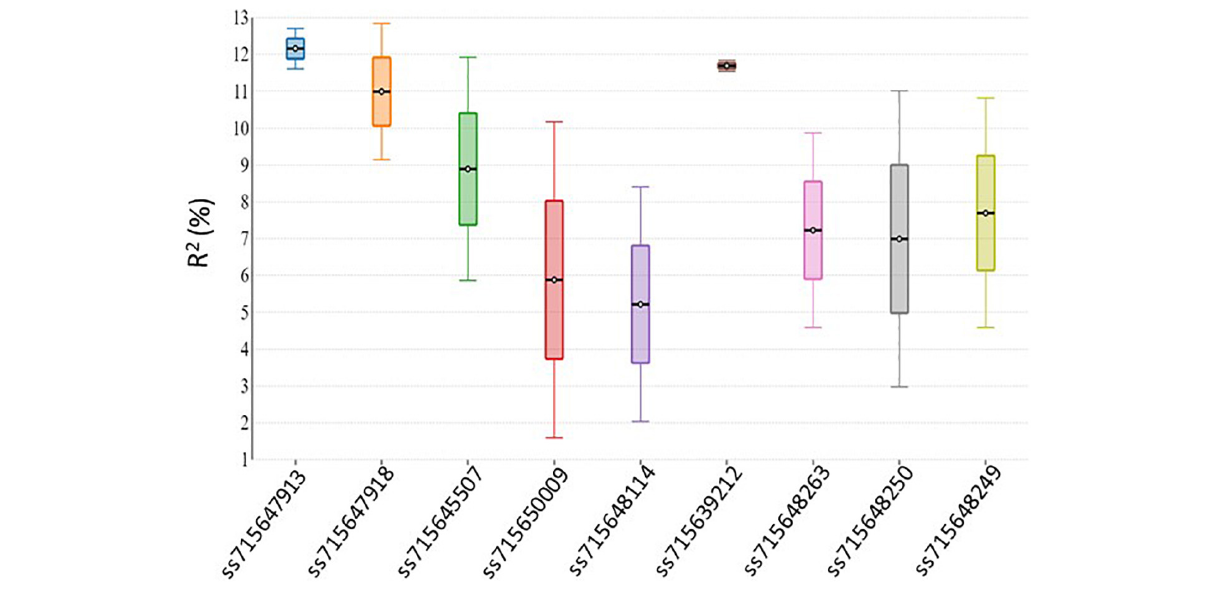
FIGURE 4 | Significant SNPs account for the percentage of phenotypic variation ( R 2 ) in 2